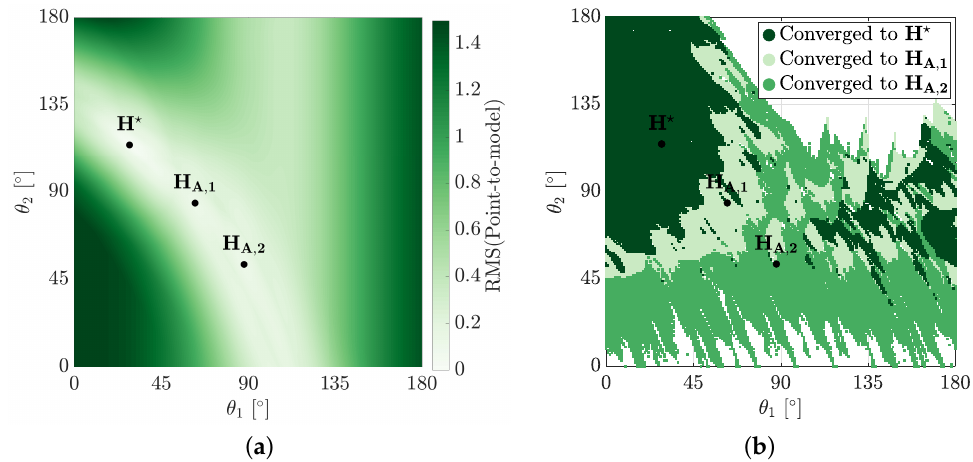
Figure 10. The RMS of point-to-model cost metric has a global minimum at, H (cid:63) , and two competing local minimums at, H A ,1 and H A ,2 . The basins are determined using a Nelder-Mead solver seeded at every 1 ◦ of θ 1 and θ 2 . ( a ) RMS point-to-model error. ( b ) Nelder-Mead seed convergence on the RMS of point-to-model cost